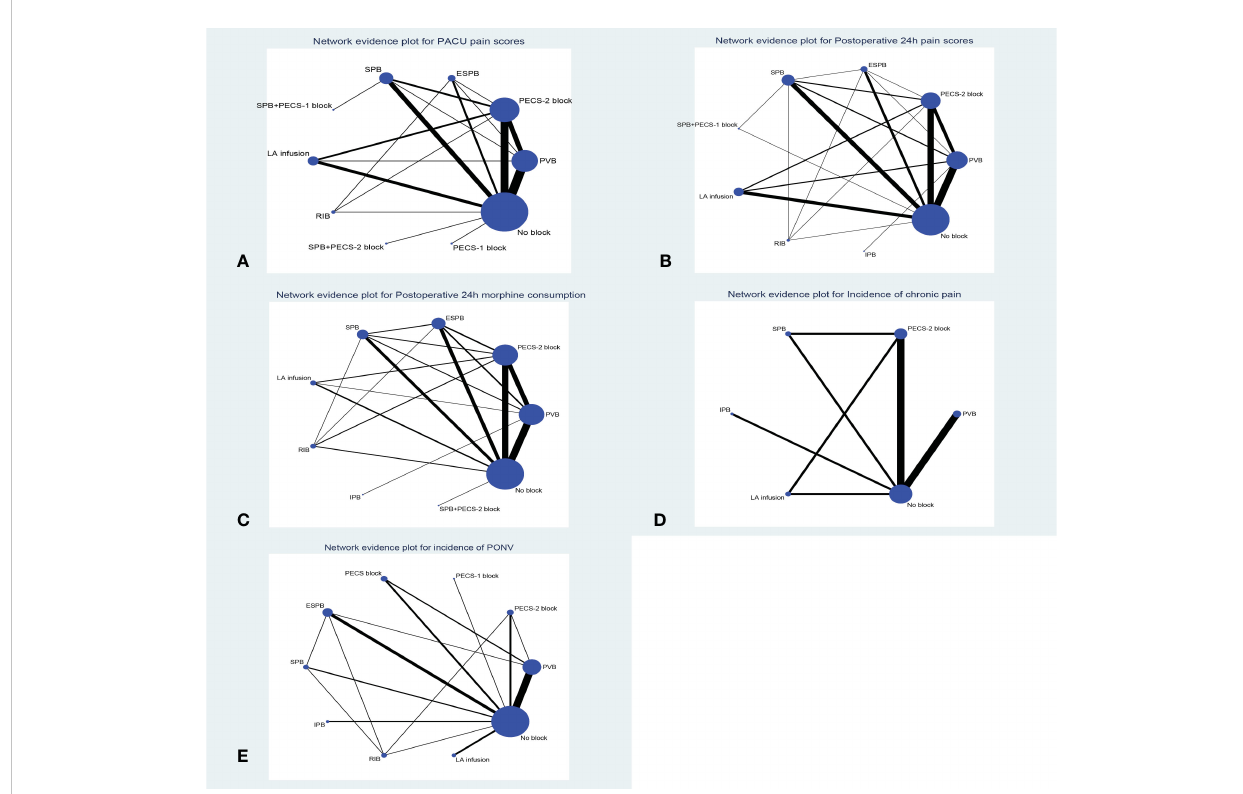
FIGURE 2 Network geometry plot (A) : PACU pain scores, (B) : Postoperative 24h pain scores, (C) : Postoperative 24h morphine consumption, (D) : Incidence of chronic pain, (E) : Incidence of PONV). Lines connect the interventions that have been studies in direct comparison in the eligible RCTs. The width of the lines represents the cumulative number of RCTs for each pairwise comparison and the size of every node is proportional to the number of randomized participants. ESPB, erector spinae plane block; PECS-2 block, pectoral nerves-2 block; PECS-1 block, pectoral nerve-1 block; PVB, paravertebral nerve block; SPB, serratus anterior plane block; IPB, interpleural block; LA infusion, local anesthetic